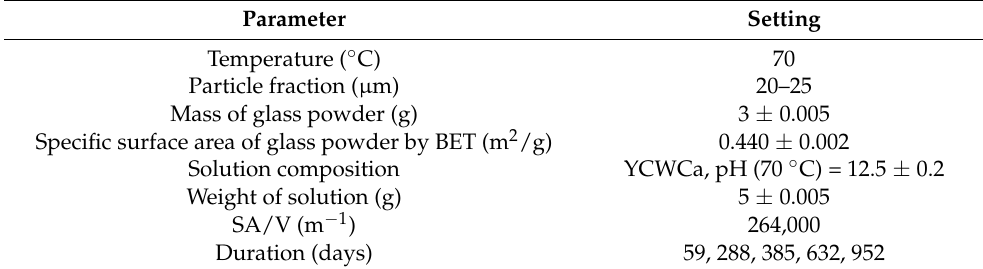
Table 2. Experimental conditions of the static glass dissolution experiments at very high SA/V